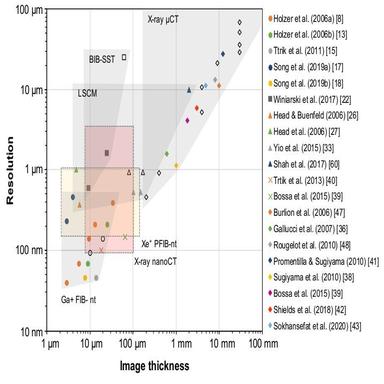
Comparison of 3D imaging techniques in terms of achievable image thickness and spatial resolution. Circles (○) denote data for FIB-nt, squares (□) for BIB-SST, crosses (×) for X-ray nanoCT, triangles (∆) for LSCM and diamonds (◊) for X-ray μCT. Empty and filled symbols represent data from present study and literature respectively. Operating regimes of Xe+ PFIB-nt and X-ray nanoCT are adapted from.